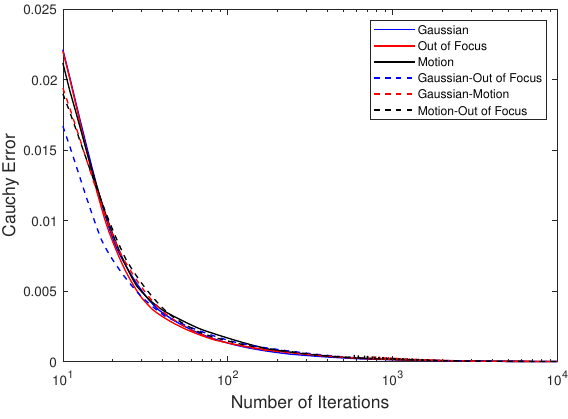
Figure 33. Cauchy error plots of the proposed algorithm in all cases of RGB images. The Cauchy error is defined as (cid:107) x n − x n − 1 (cid:107) < 10 − 8 . The figure error is defined as (cid:107) x n − x (cid:107) , where x is the solution of the problem (VIP). The performance of the proposed algorithm at x n in